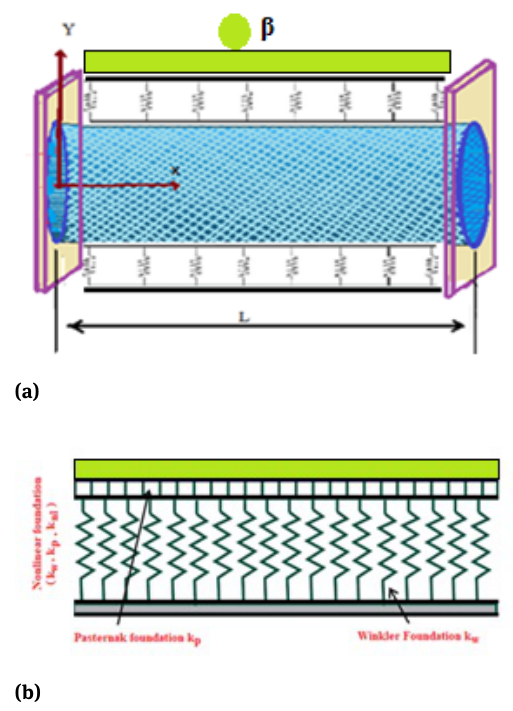
Figure 3: Geometry of SWCNT in (a) polymer matrix; (b) nonlinear